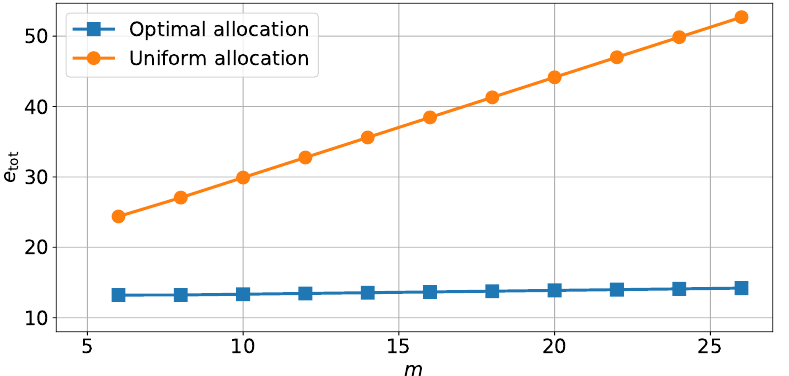
Figure 7. Energy needed to store each variable in an unreliable memory to achieve a variance of esti- mation error on the position P N | N [ 0,0 ] = 15, depending on the number m of bits in the representation.